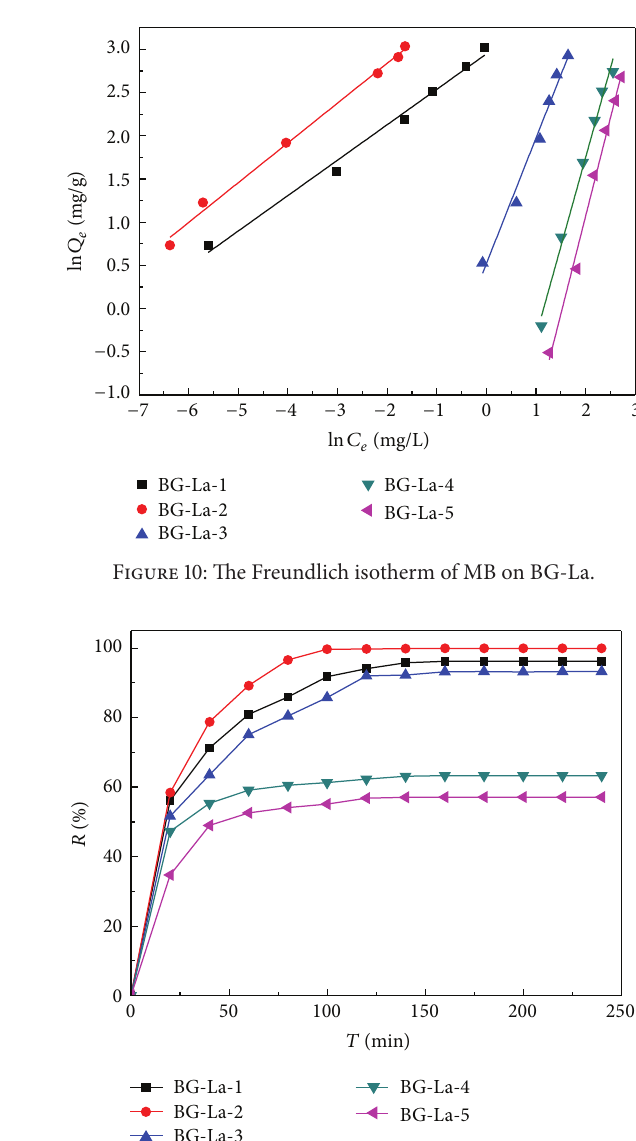
Figure 11: 𝑅 ( % ) plotted against time for BG-La materials under UV light